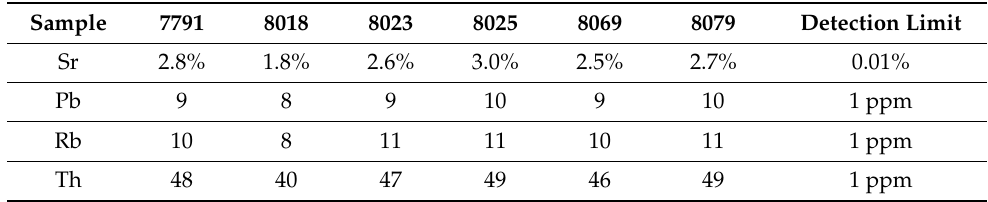
Table 2. Trace element content of selected barite samples by